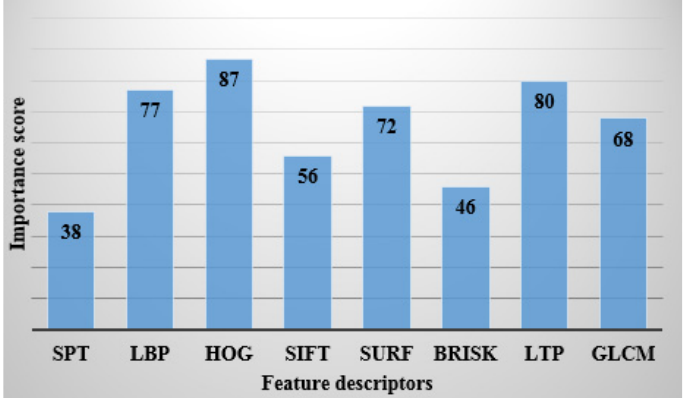
Figure 4. Feature importance